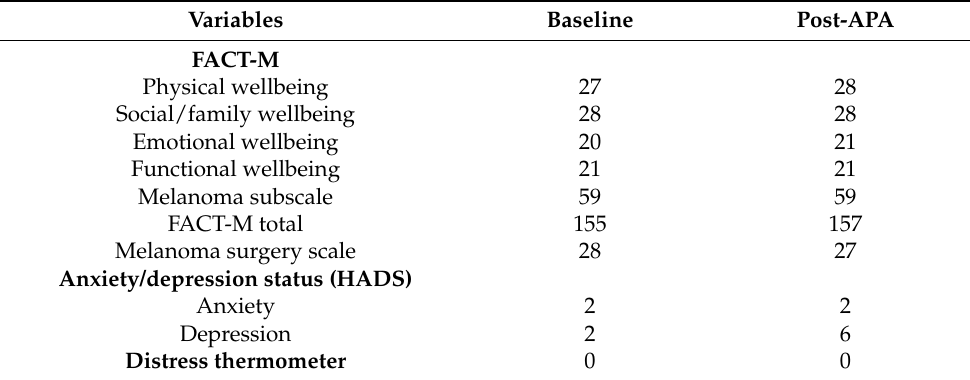
Table 4. Mean scores of quality of life, anxiety/depression status, and distress thermometer question- naires at baseline and post-adapted physical activity intervention.